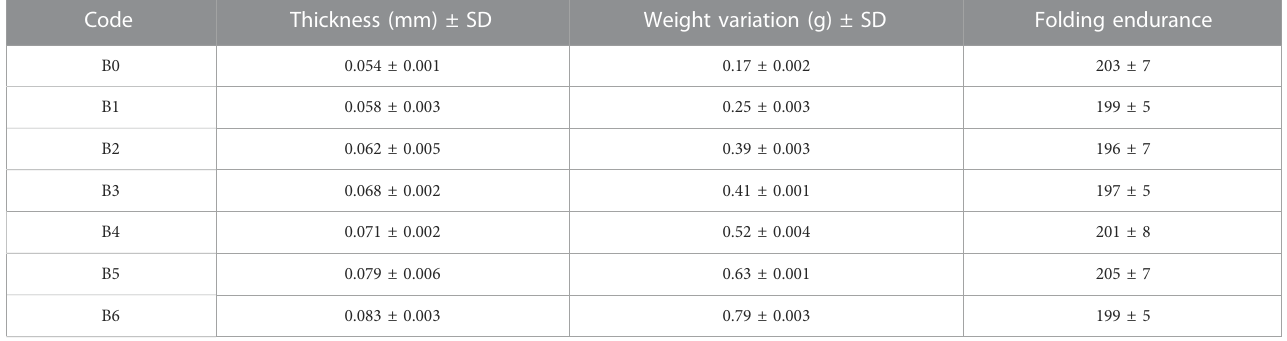
TABLE 2 Thickness, weight variation, and folding endurance of hydrogel fi lms (n = 10).